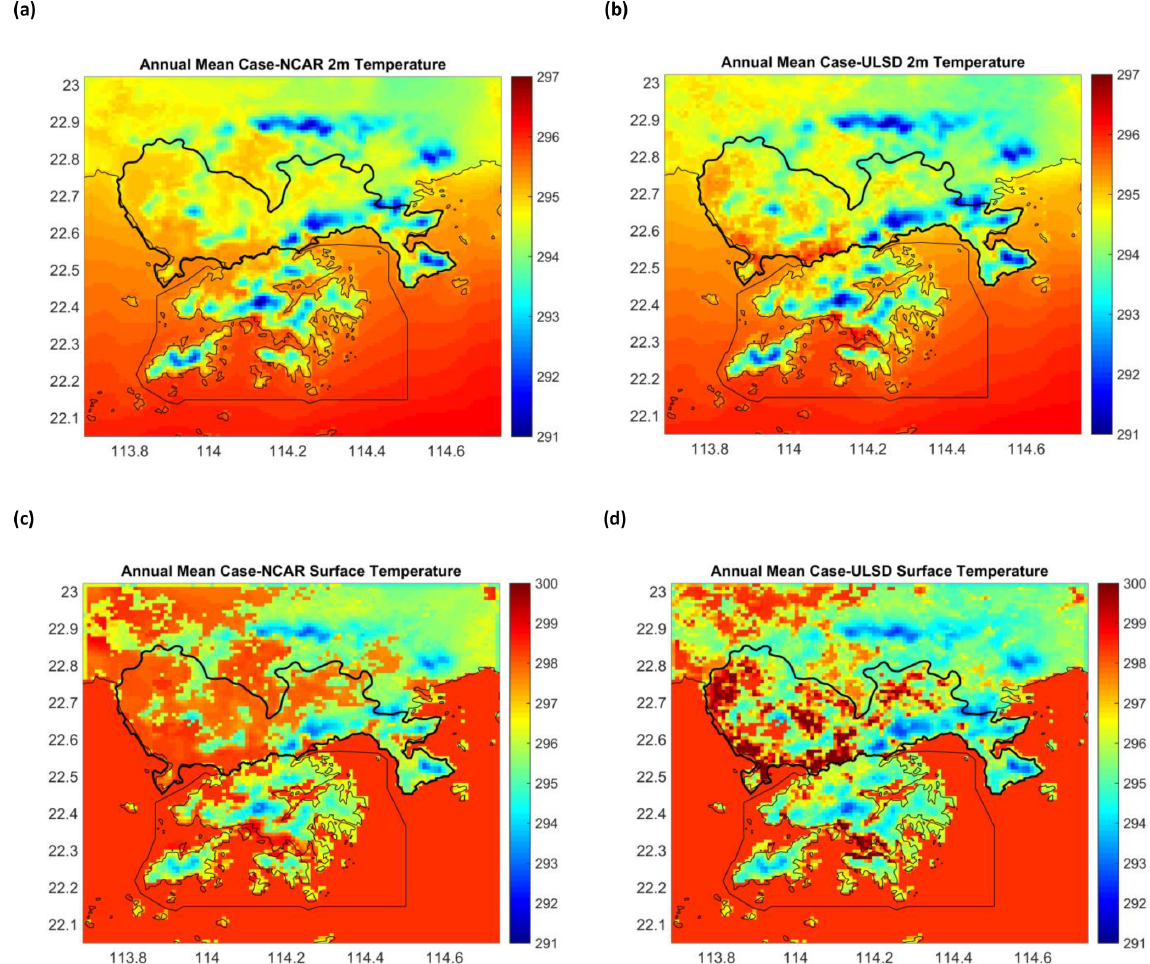
Figure 9. Spatial distribution of 2m air temperature and surface temperature of Case-NCAR (a, c) and Case-ULSD (b, d) . Data source: Li et al. (2019a, b).